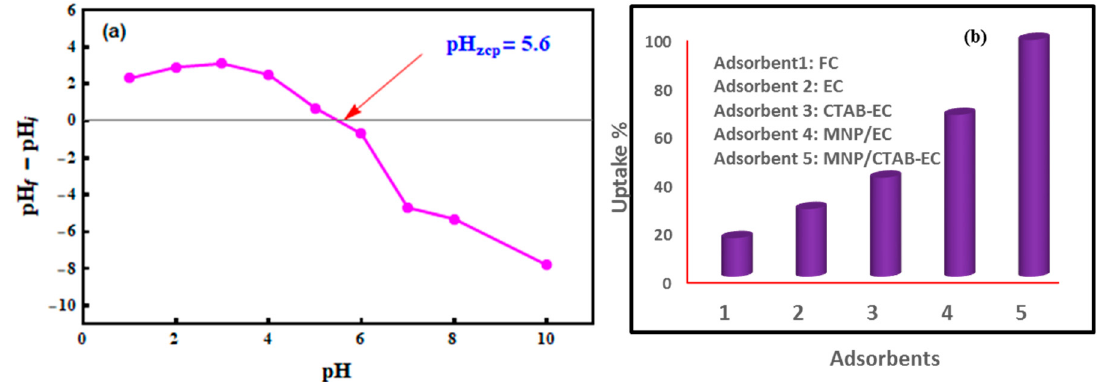
Figure 4. ( a ) pH at zero-point charge (pH ZCP ) of MNP/CTAB–EC and ( b ) removal efficiency (%) of the FC, EC, CTAB-EC, MNP/EC and MNP/CTAB–EC for CV dye at pH 8.0.